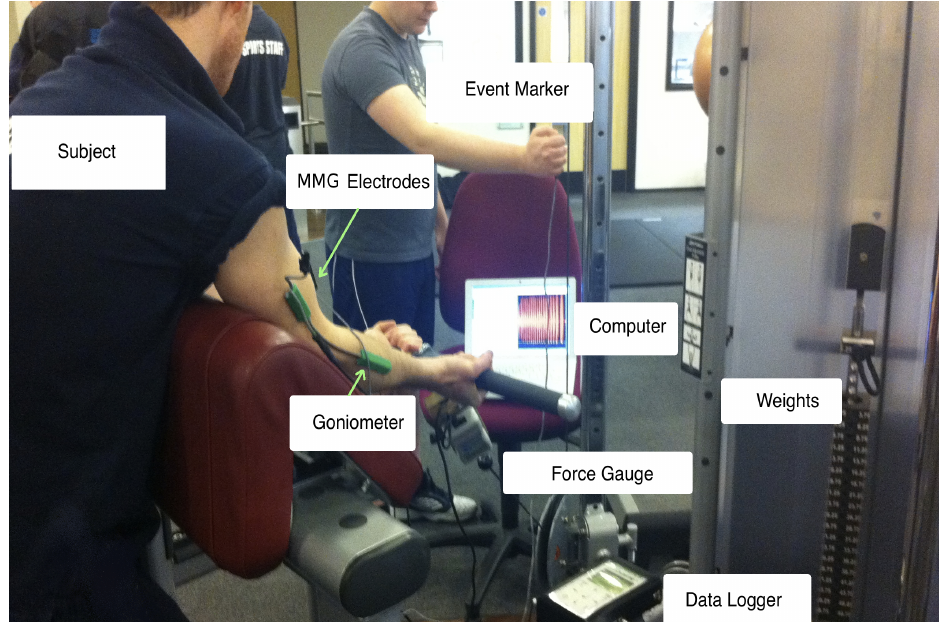
Figure 1. Experimental set-up showing one of the